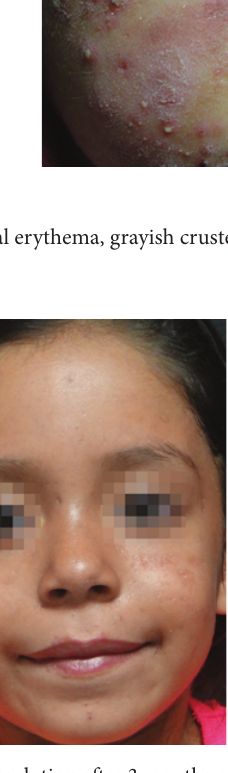
Figure 2: Clinical resolution after 3 months of